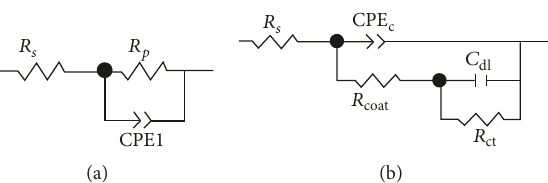
Figure 13: Proposed equivalent circuits for (a) bare steel, (b) galvanized steel, rGO film, and rGO-Zn coating for numerical simulation of the EIS